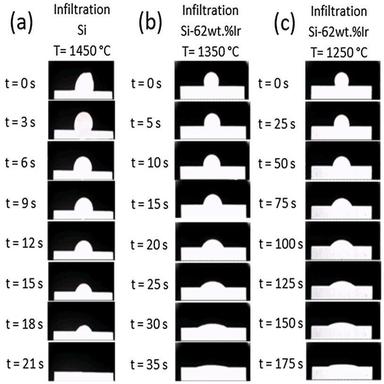
Images of drop profiles recorded during infiltration experiments performed on SiCp-C preforms with: a) Si at T = 1450 °C, b) Si-Ir eutectic alloy at T = 1350 °C and c) Si-Ir eutectic alloy at T = 1250 °C.